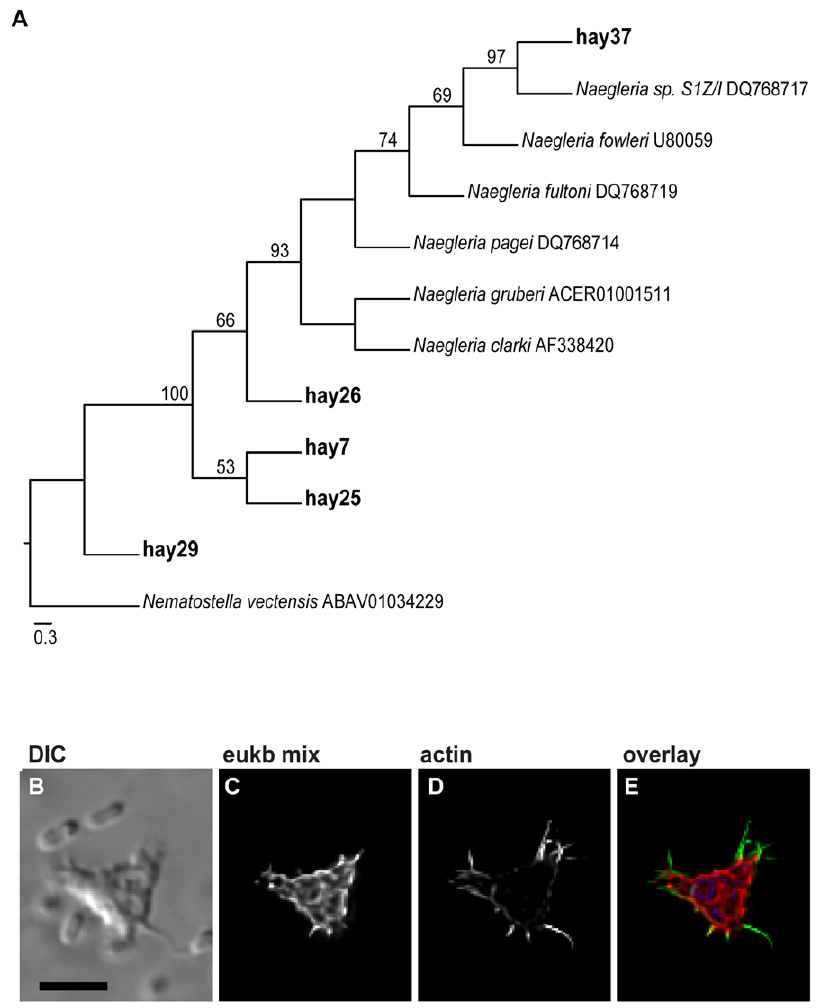
Figure 3. Amoebae found in the hay infusion enrichment are closely related to Naegleria spp. The evolutionary relationships of the rDNA sequences from the hay infusion were determined by bootstrap analysis using RAxML and are presented in A (only bootstrap values $ 50% are shown above the branches). Accession numbers follow the species name and sequences identified in this study are represented by the name ‘‘hay’’ followed by the accession number (A). The eukaryotic rRNA-targeted FISH (C) overlaid with the phalloidin (actin) stain (D) links phylotype with amoeboflagellate morphology in the hay infusion enrichment (B–E). The image overlay (also see 3D stack in Video S3) shows the eukaryote ssu rRNA probe (green), phalloidin stain (red), and DAPI nucleic acid stain (blue) (E). Scale bar=10 m